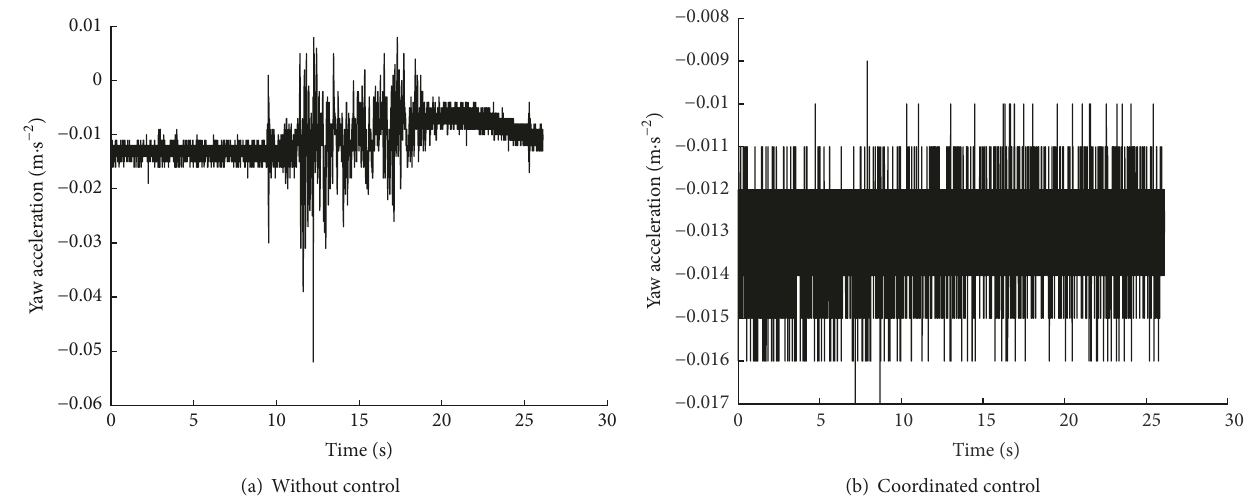
Figure 5: Measure results of yaw acceleration of